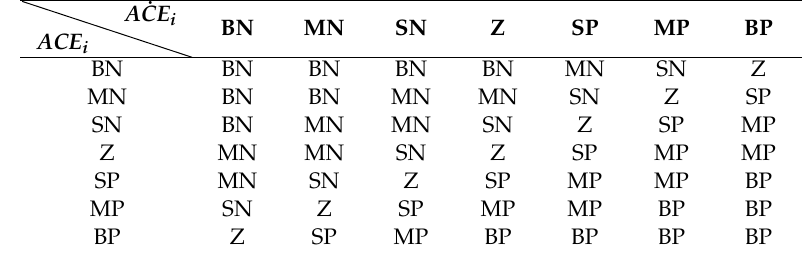
Figure 3. GLFC with two-level control structure. Table 2. GLFC fuzzy rules.